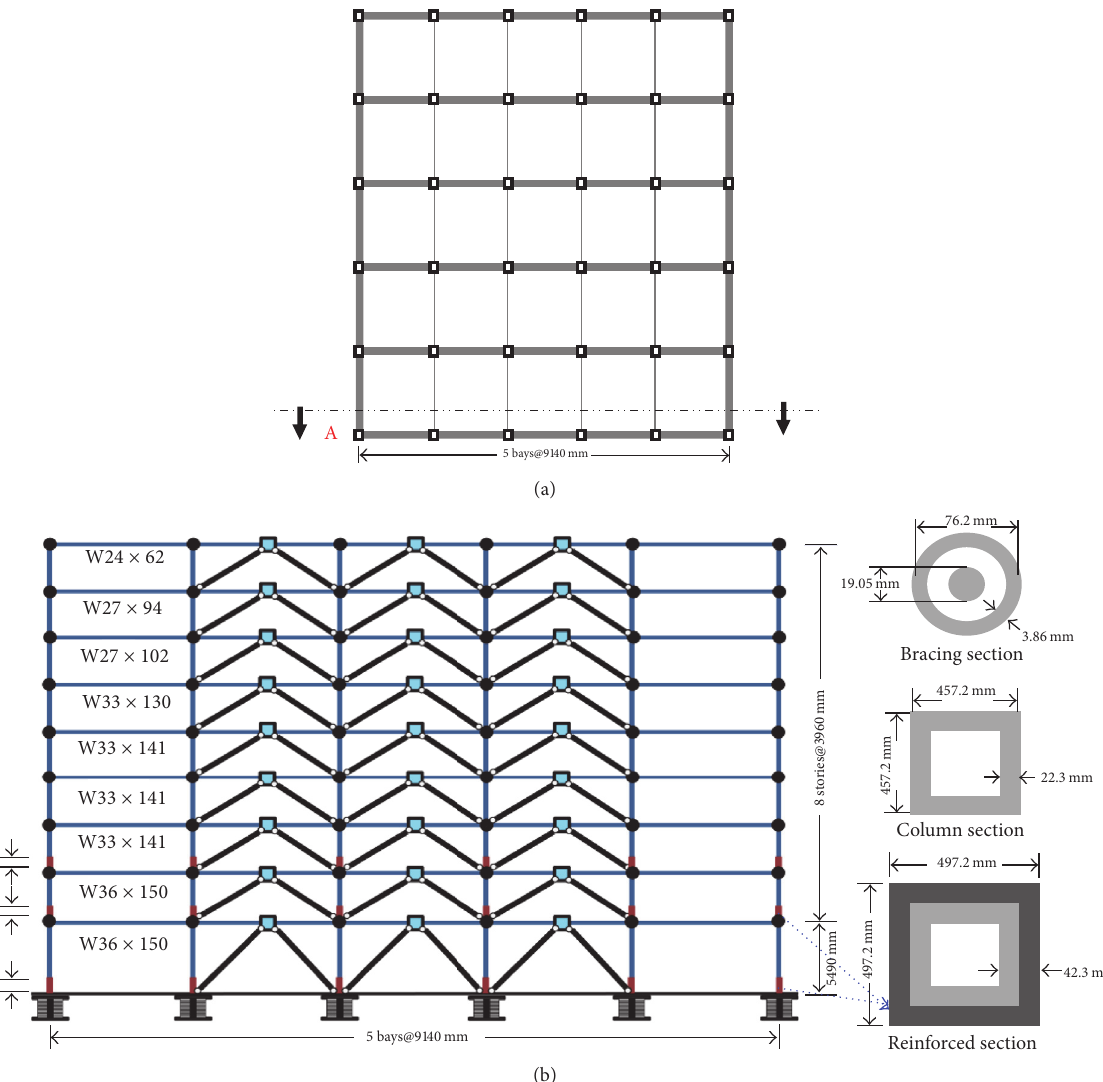
Figure 4: A nine-story building employing an LRB isolator system with LRB isolation system (a) building plan and (b) elevation view of section A and sections details.